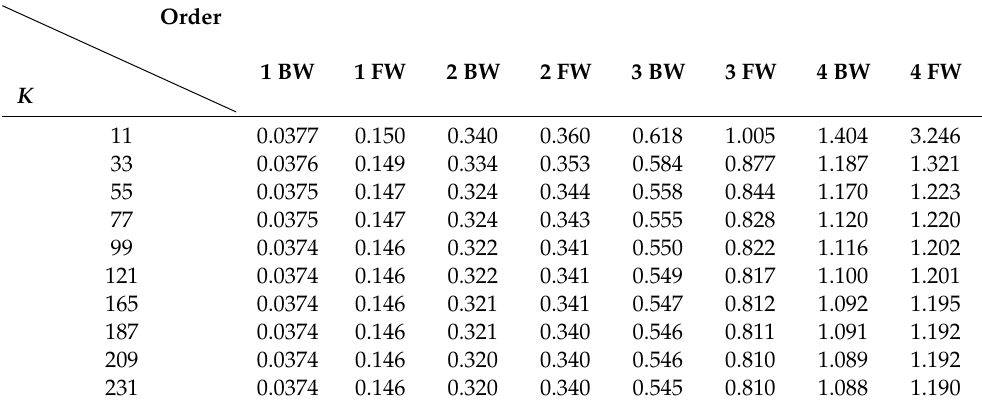
Table 2. Natural frequencies via modal discretization ( h = 100 Nms).